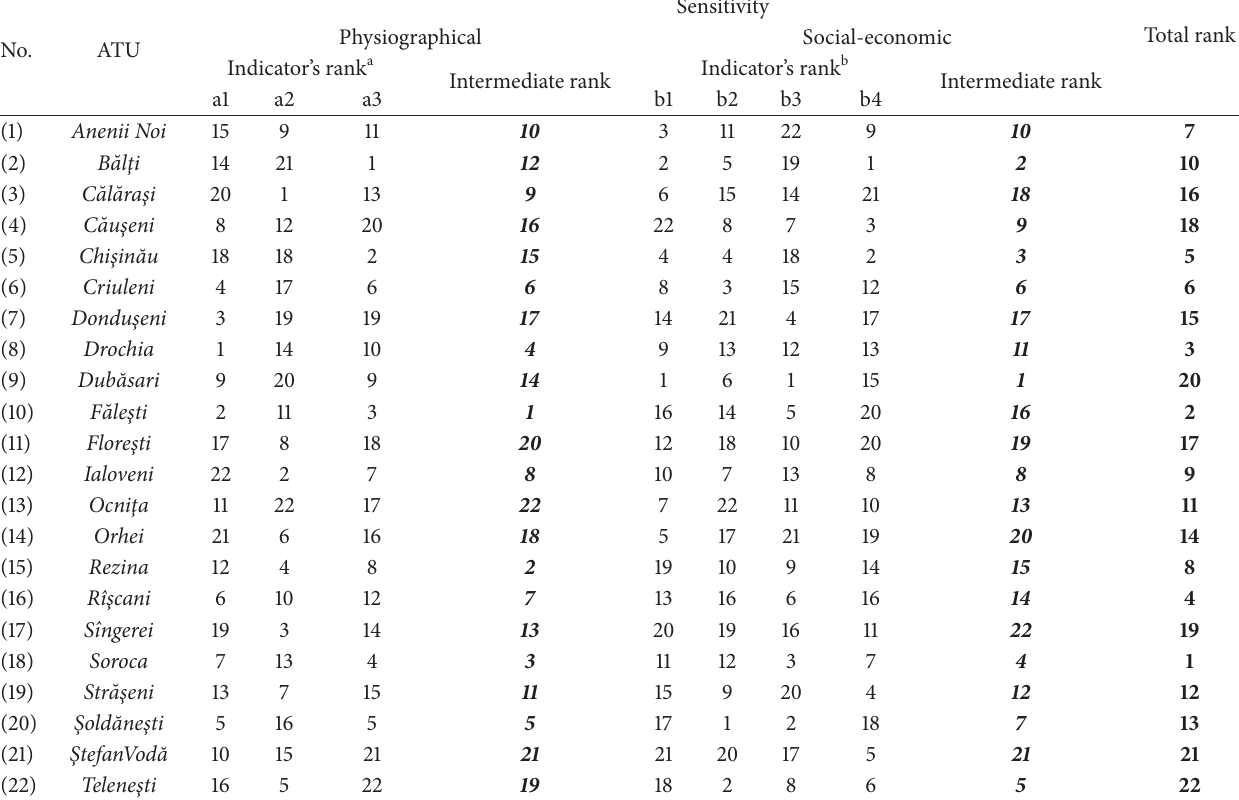
Table 4: Ranks of Moldova’s administrative-territorial units in the decreasing order of their sensitivity.